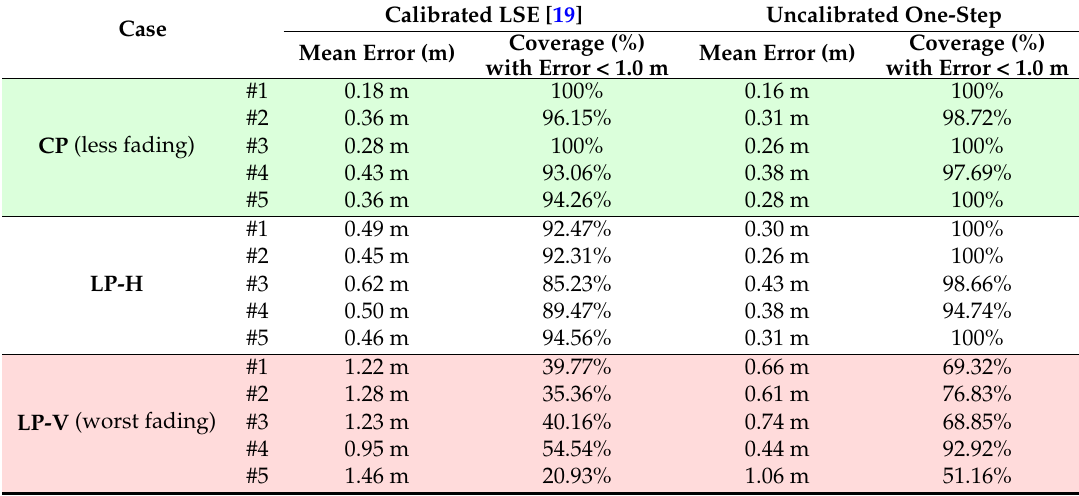
Table 4. X-path Tracking estimation error results @ z REF = 1.10 m.